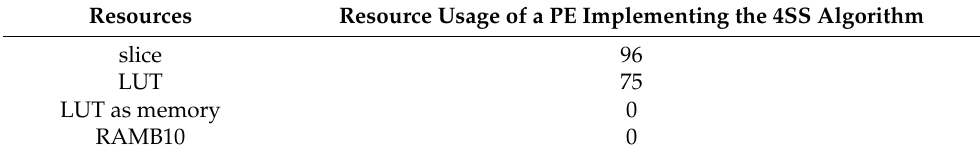
Table 1. Resource usage of a reconfigurable PE.